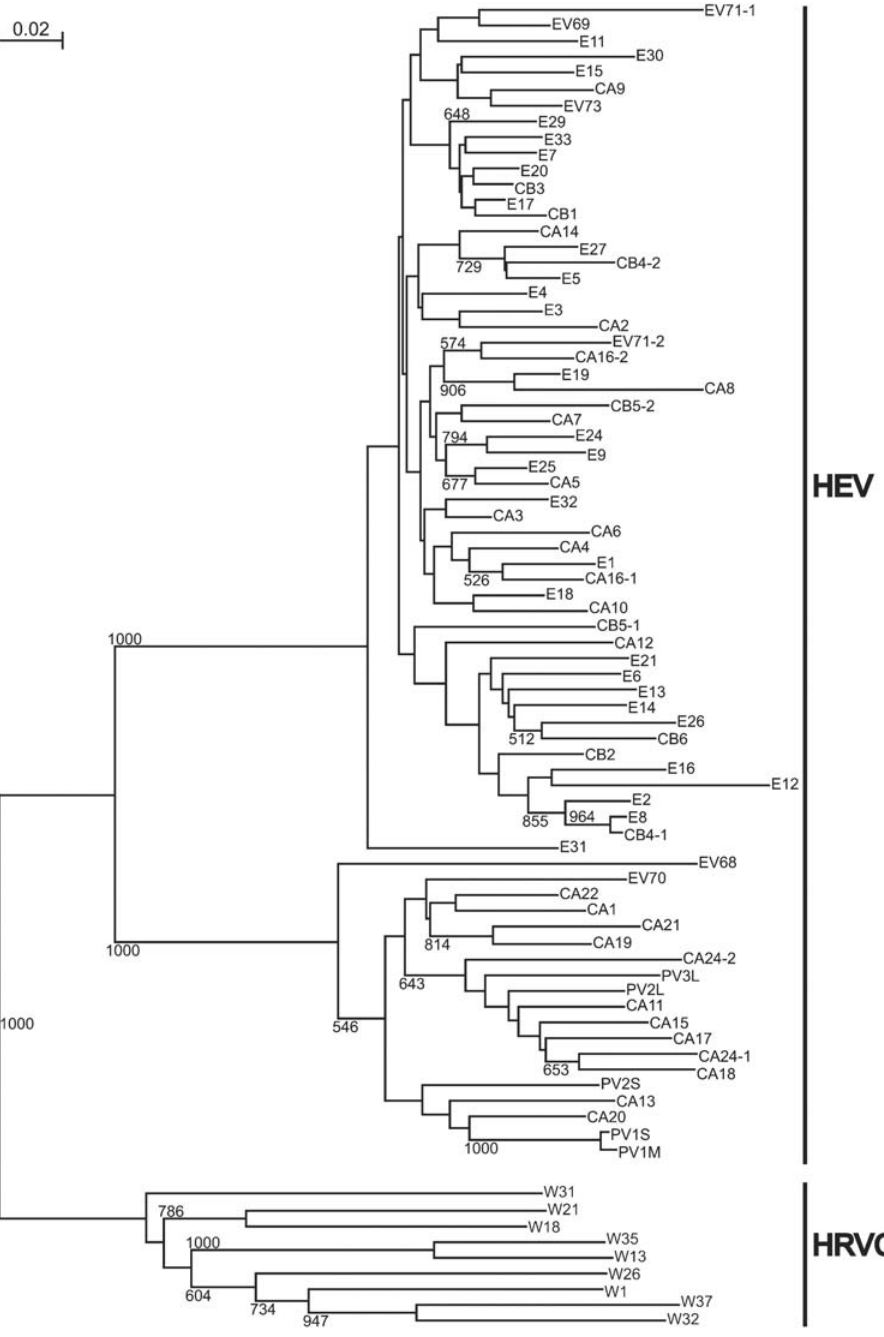
Figure 5. Phylogenetic tree depicting the relationships between 9 HRVC strains (W in red) and all known HEV (n=74) in the P1-P2 region of 5’NCR. HEV include polioviruses (PV), coxsackieviruses A (CA), coxsackieviruses B (CB), echoviruses (E) and the newer numbered EVs. For 5 serotypes (CA16, CA24, CB4, CB5 and EV71), 2 different P1-P2 sequences were found in GenBank. This tree was generated as described in Figure 3. HRVC and HEV clustered into 2 different